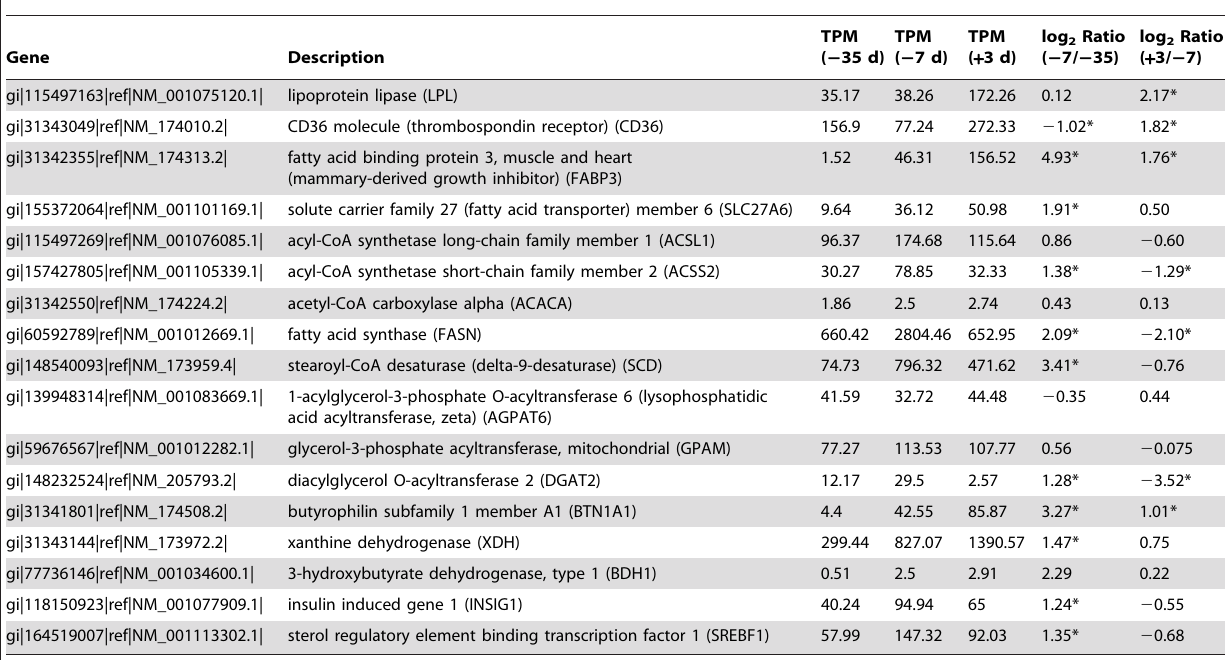
Table 6. Expression changes of lipogenic genes during the two stages of lactogenesis.